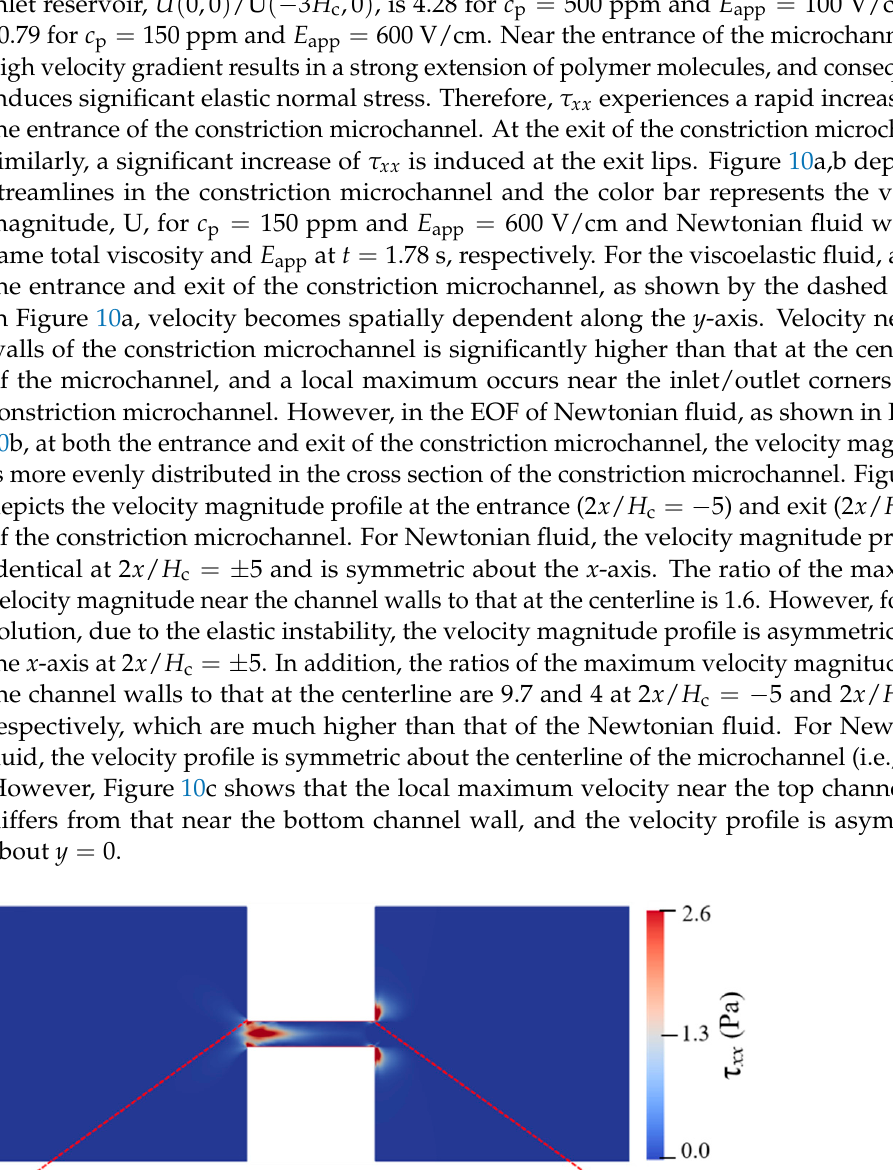
Figure 9. Spatial distribution of the elastic normal stress τ xx for c p = 150 ppm and E app = 600 V/cm at t = 1.78 s.